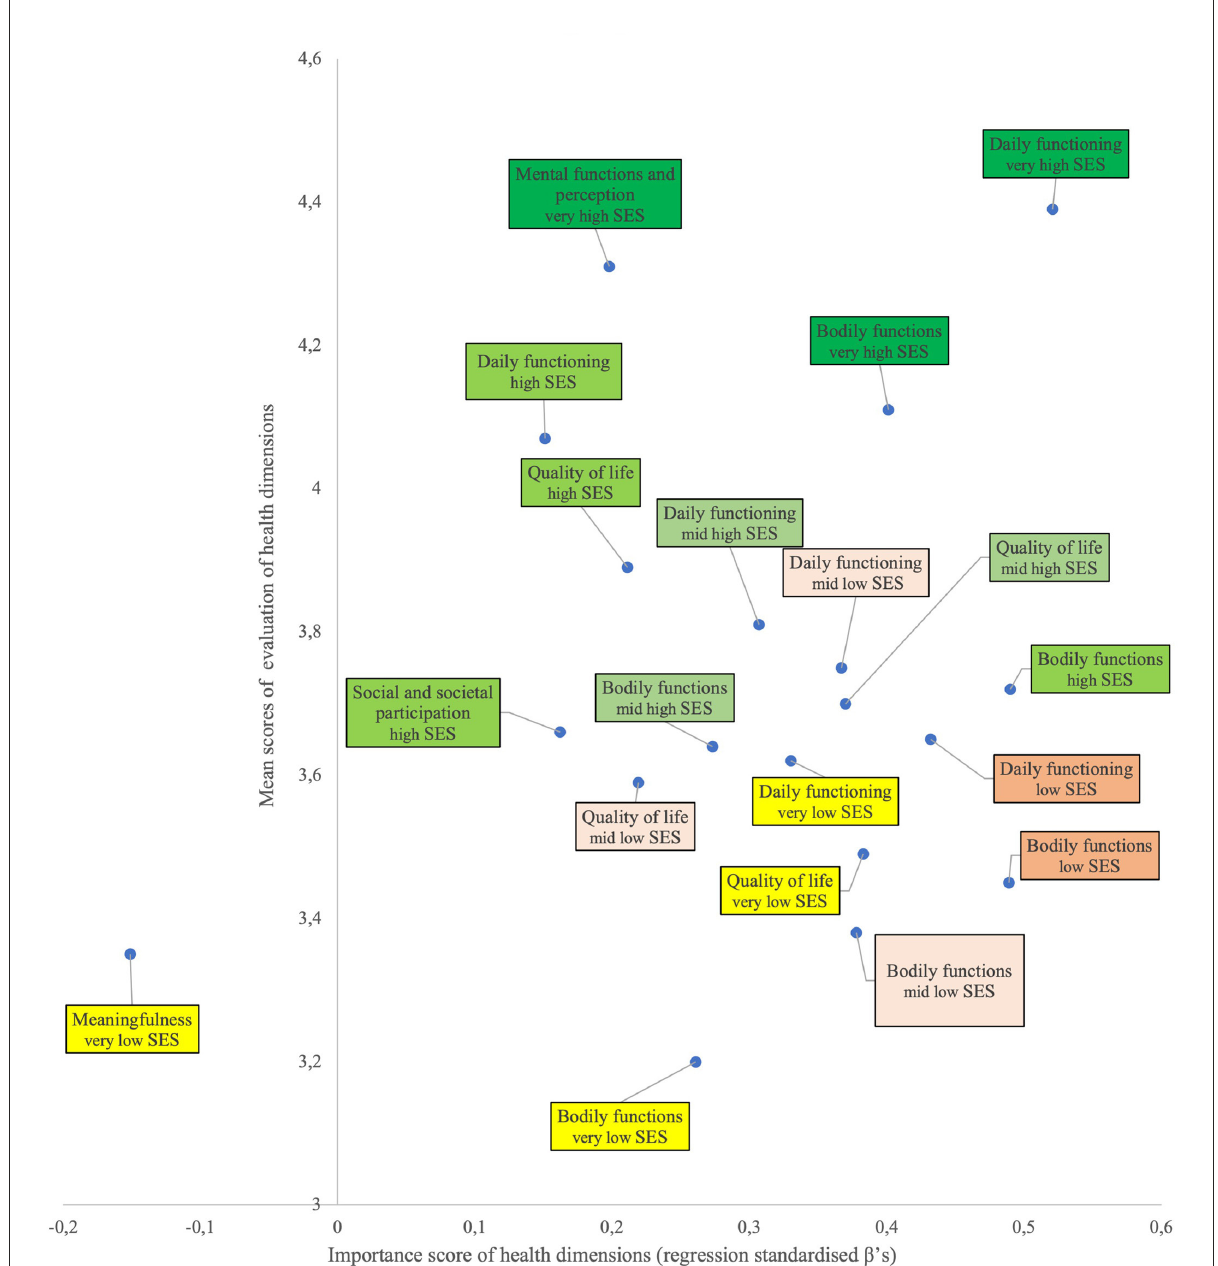
FIGURE6 Significant importance and mean scores per health dimension for all six SES groups. The relation between the standardised β ’s of the regression analysis as a measure for significance of impact (importance score; horizontal axis) and the mean score of the evaluation of each of the six health dimensions (vertical axis) per SES group. A higher score on the horizontal axis means bigger impact on the health dimension in the SES-group. A higher score on the vertical axis means a higher mean score of the health dimension in the SES group. The position in the graph is a measure for the importance of a health dimension and the way this dimension is valued by a person in a SES